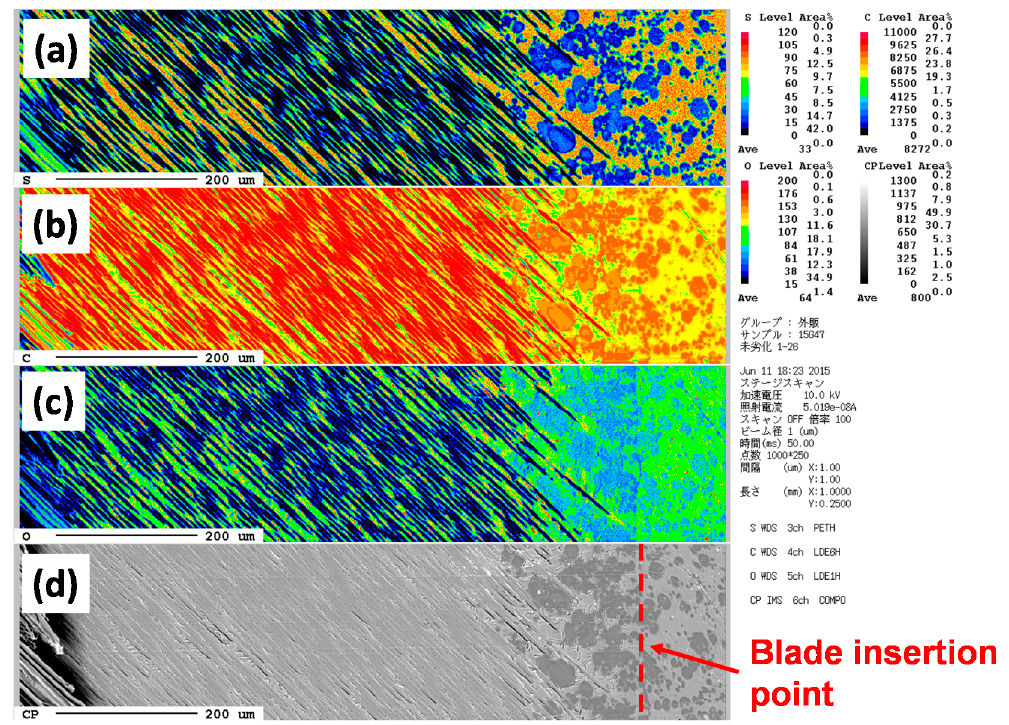
Figure 16. EPMA mapping of CFRP sample for sulfur ( a ), carbon ( b ) and oxygen atoms ( c ). Image ( d ) shows the SEM image with the marked measurement position.